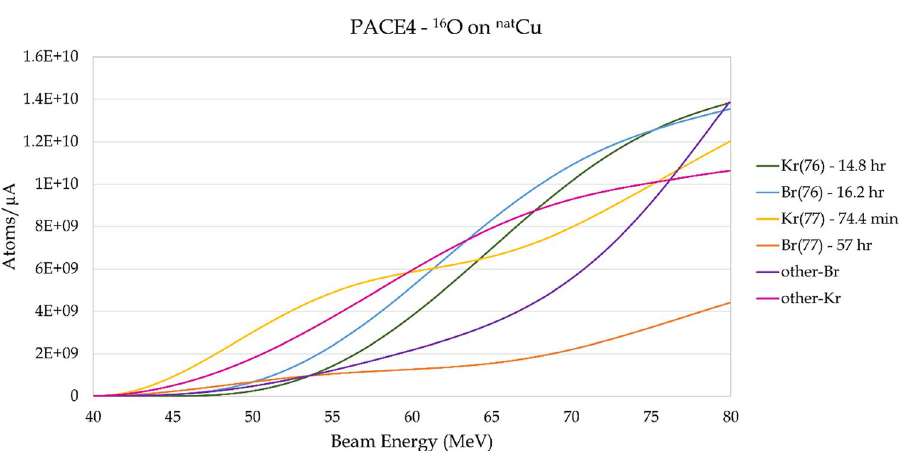
Figure 3. PACE4 predicted yields for a 20-min run of 16 O on nat Cu as a function of laboratory bombarding energy. The mass-76 and mass-77 isobar chains are shown explicitly, while all contaminant isotopes are shown summed